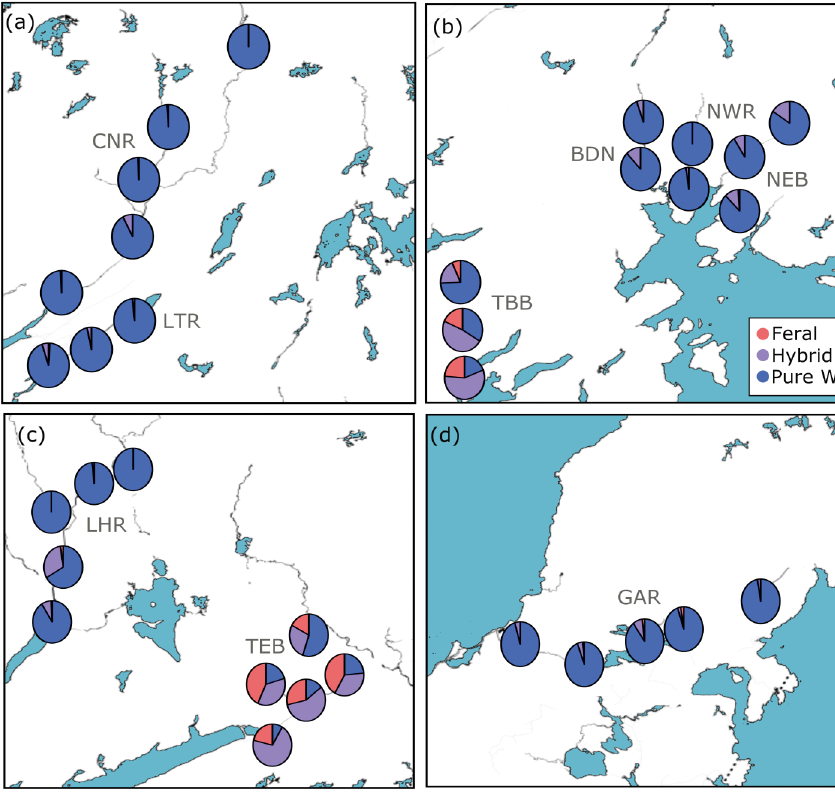
Fig. 3. Population composition of Atlantic salmon parr as feral, hybrid, or pure wild at all 35 sites across 9 rivers in southern Newfoundland, Canada. Panels correspond to geo- graphic areas designated in Fig. 1. Abbreviations are listed in Table 1. Points have been slightly shifted for visibility of pie graphs; refer to Fig.